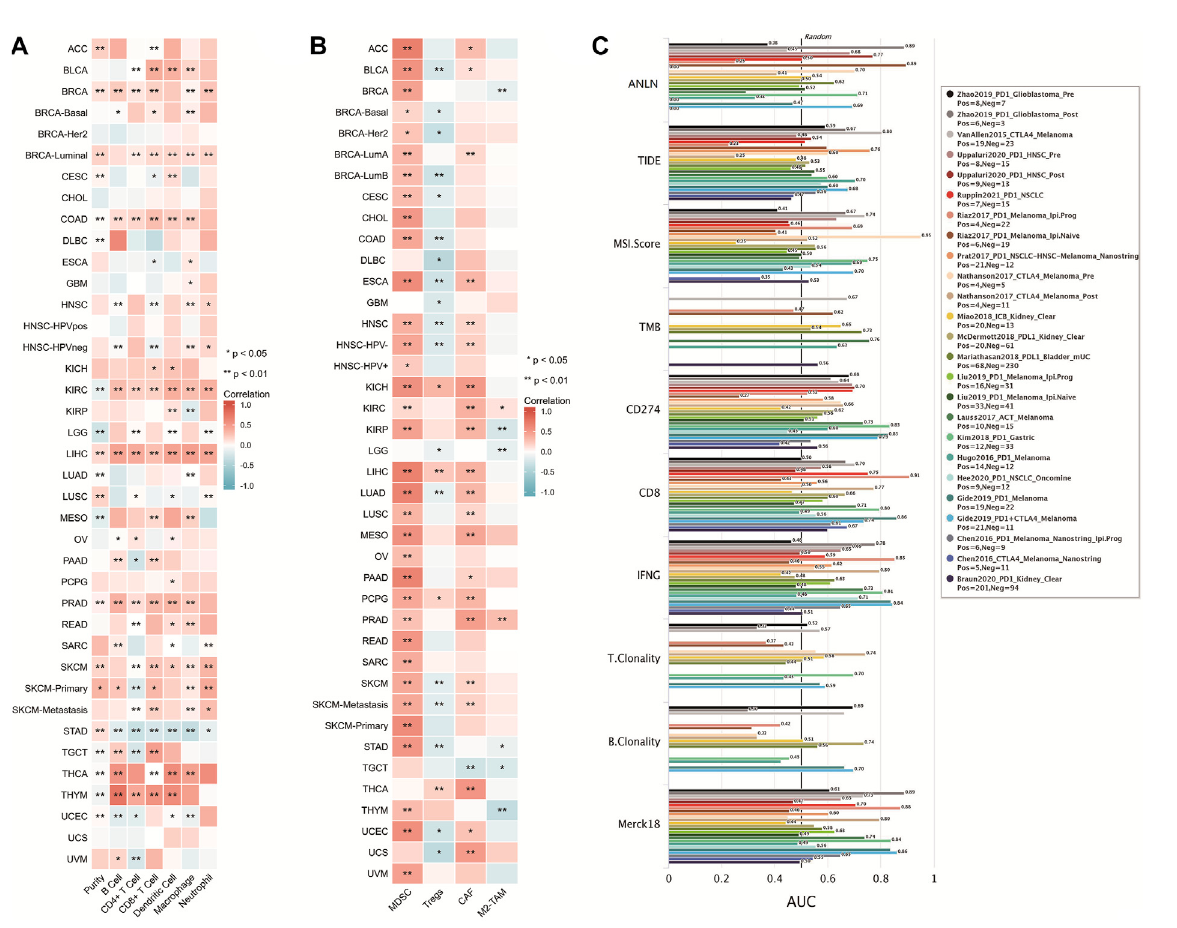
FIGURE 7 Correlation of ANLN with tumor immune cell in fi ltration. (A,B) Heat map showing a correlation between ANLN protein and in fi ltration of six types of immune cells and four types of immunosuppressive cells in multiple tumors; (C) Comparison of ANLN with other biomarkers for ef fi cacy prediction of immunodetectable point-of-care